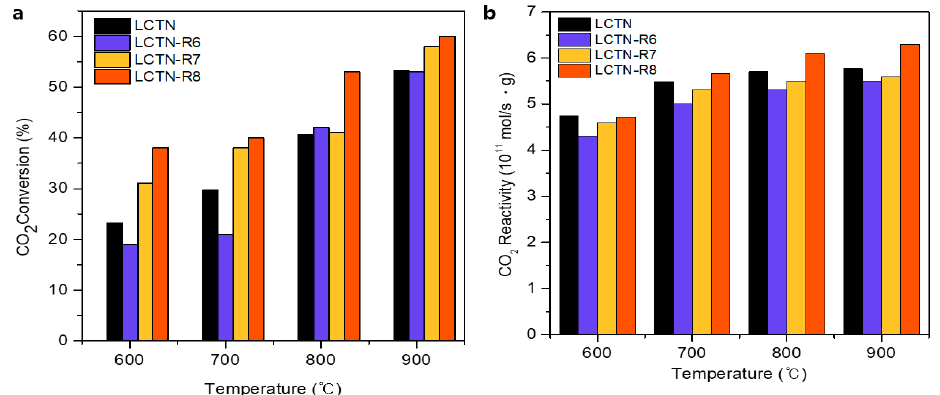
Figure 6. ( a ) CO 2 conversion and ( b ) CO 2 reactivity for CO production rate. As indicated in Figures 5 and 6, the overall CO 2 conversion and CH 4 reactivity of LCTN-R8, with values of 60.2% and 6.3 × 10 11 mol/s · gcat, respectively, were higher